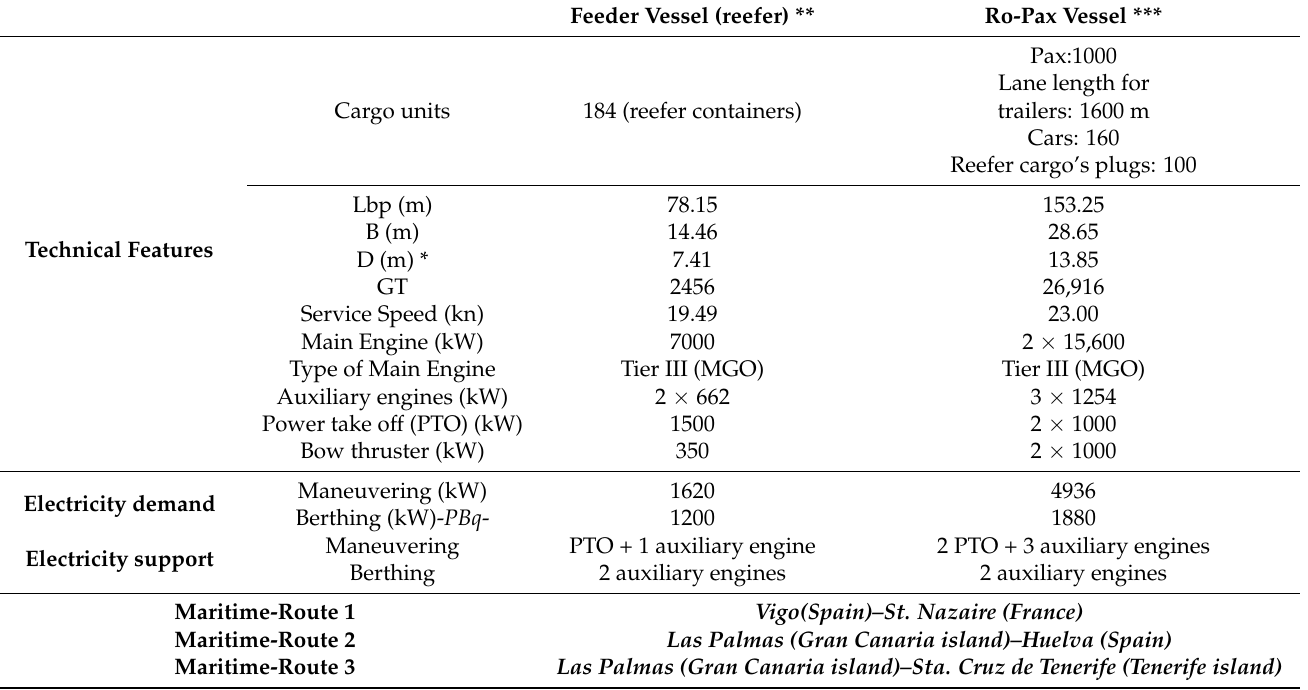
Table 1. Technical features of the fleets considered for the application